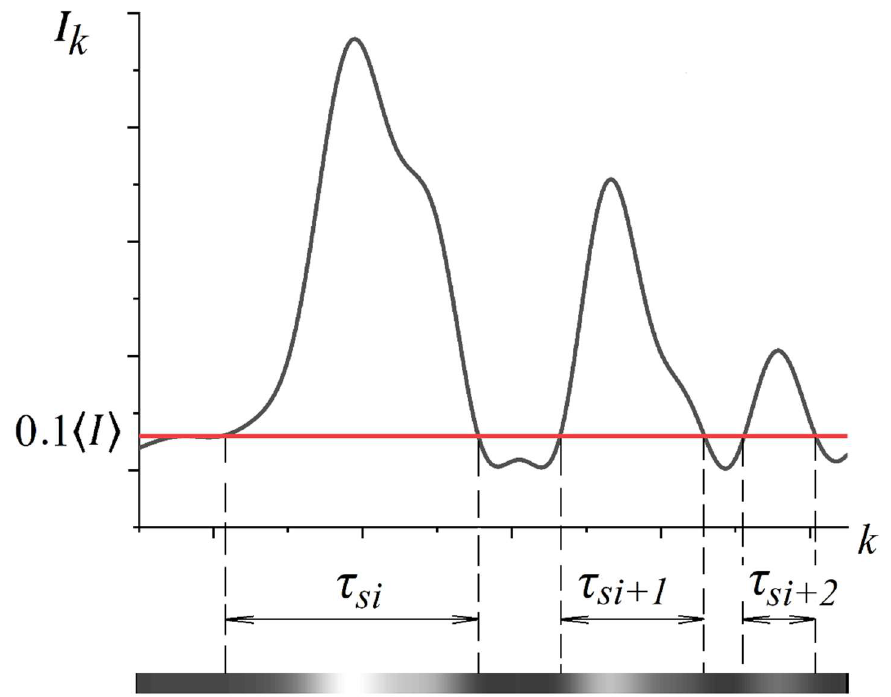
Figure 5. A fragment of the model dependence { I k } for an ensemble of phasors with regular phase modulation and the corresponding part of the model SSH trace for a fixed detection point.